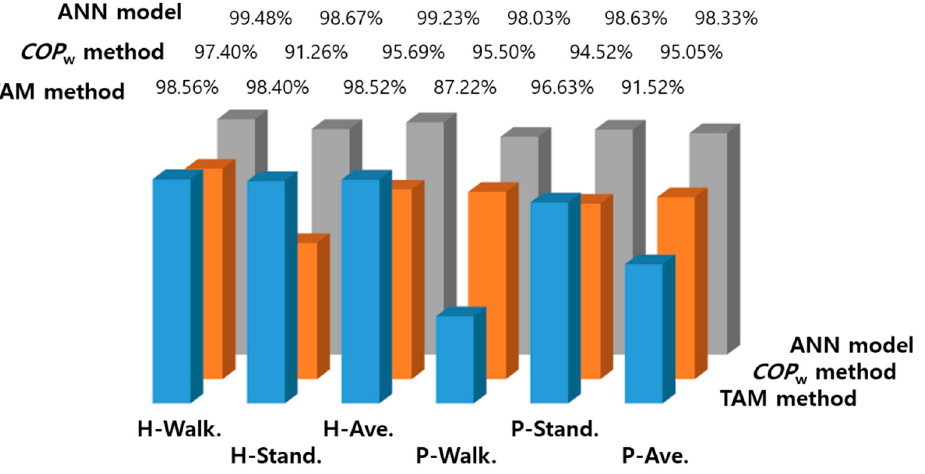
Figure 6. Comparison of the classification accuracies: H-, healthy adults; P-, patients.